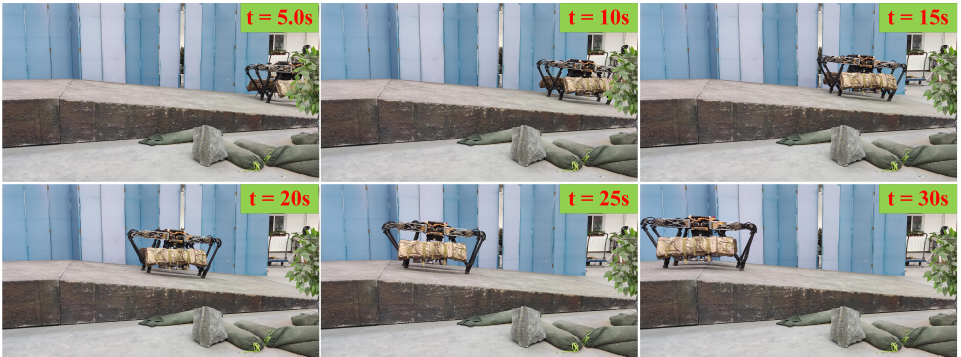
Figure 13. Snapshots of the 12° slope